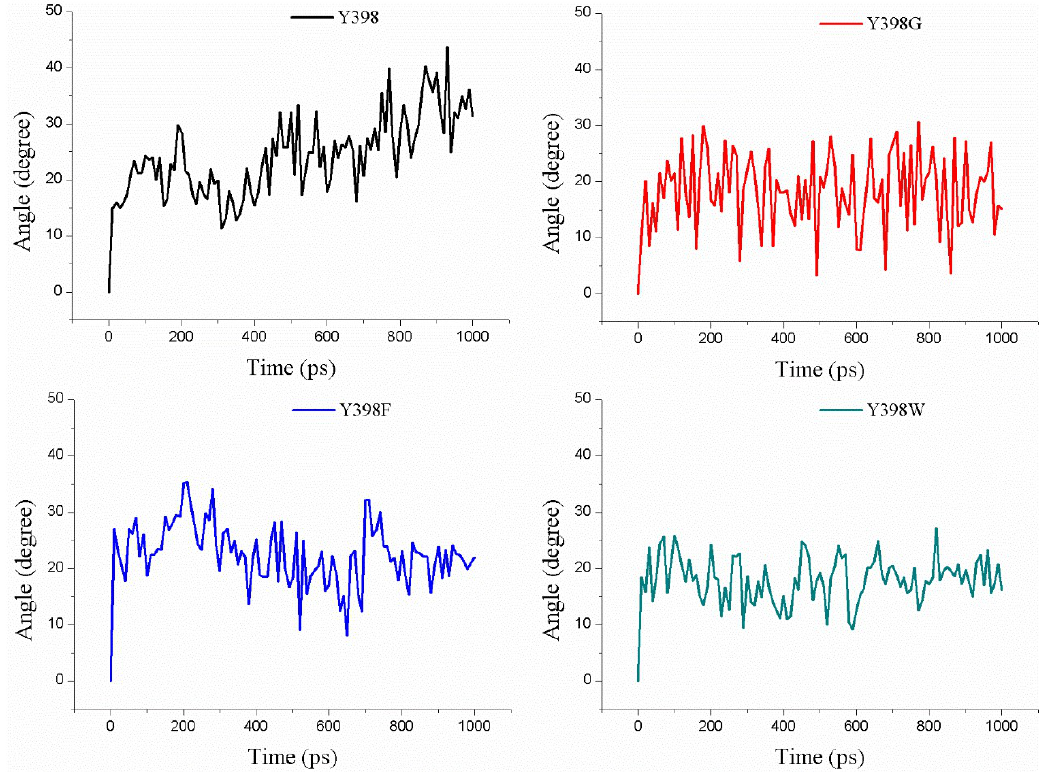
Figure 10. Rotation angle changes of Y/G/F/W398 within Carbofuran-3-hydroxy pulling process.